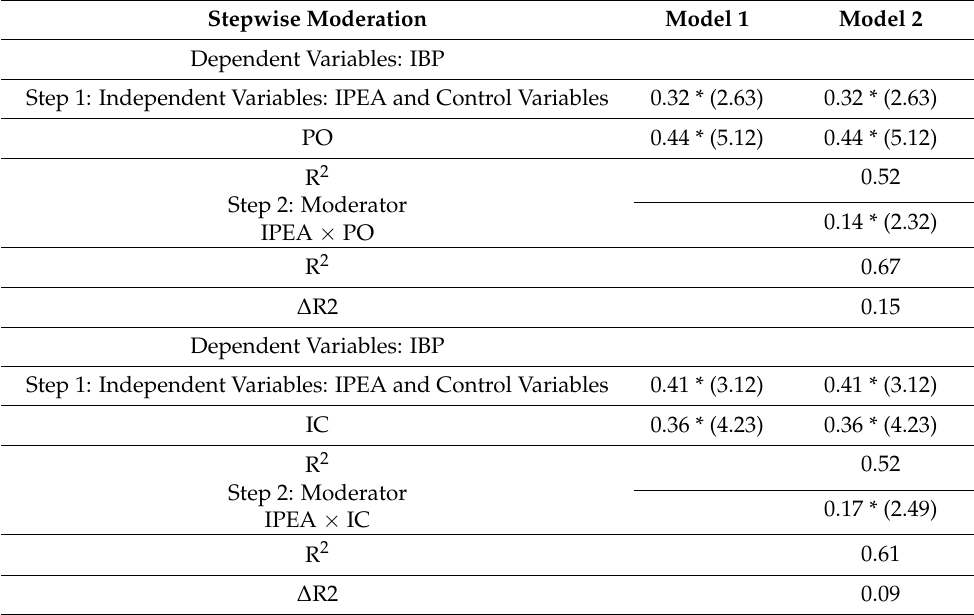
Table 6. Moderation of cultural dimensions